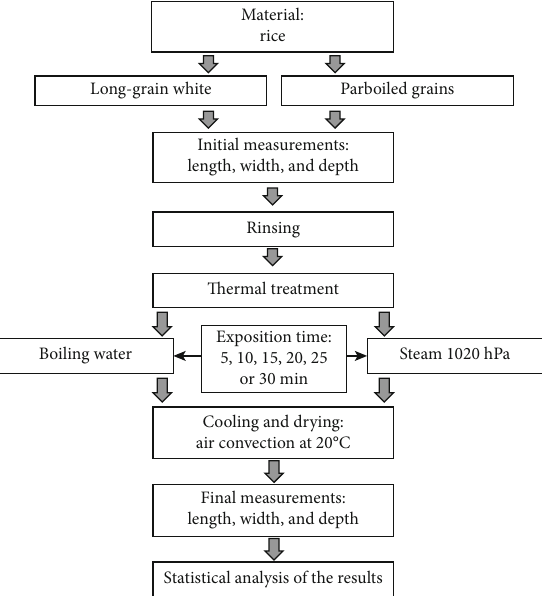
Figure 2: Block diagram of the conducted